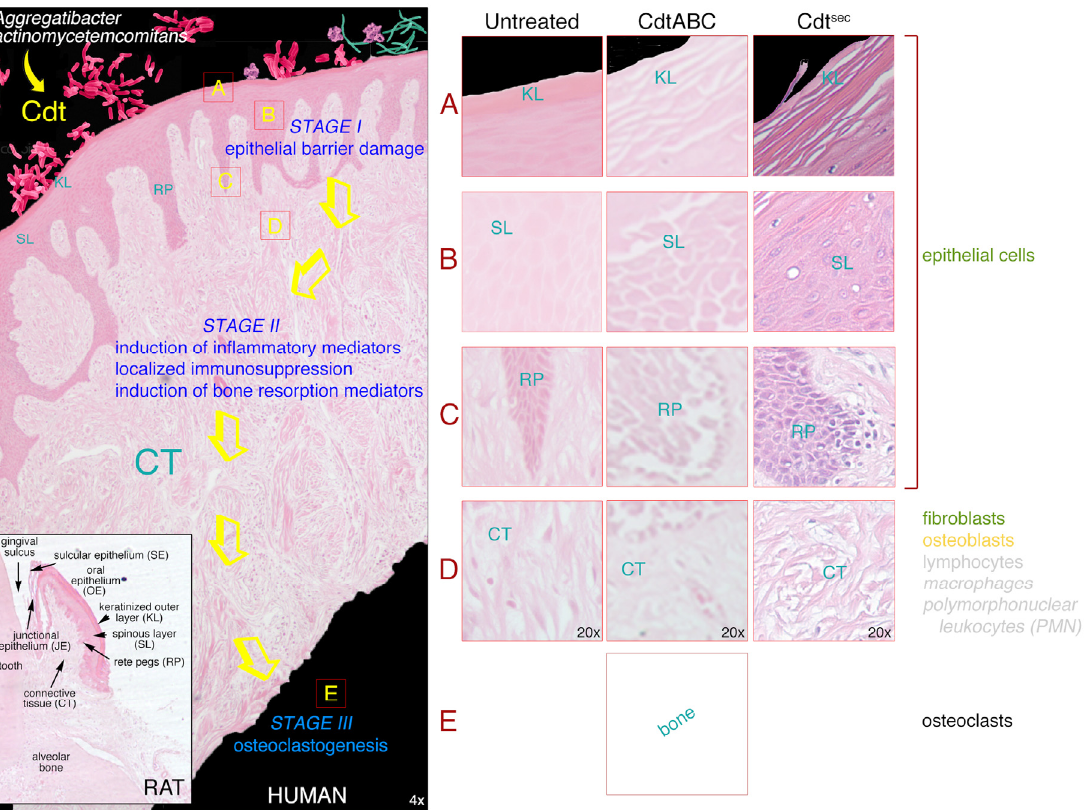
Figure 4. Human gingival explant (HGX) model of the effects of secreted Aa Cdt on tissue obtained from clinically healthy subjects. HGX were untreated or exposed to recombinant wild-type Aa Cdt (CdtABC) or native toxin secreted by the bacterium (Cdt sec ). Tissue sections were stained with hematoxylin and eosin. Abbreviations: KL, keratinized layer; SL, spinous layer; RP, rete peg; CT, connective tissue. Inset shows the overall histology of the gingival tissues and various types of epithelium (junctional, sulcular and oral) in the upper jaw of a rat. The tissue was decalcified, sectioned and stained with hematoxylin and